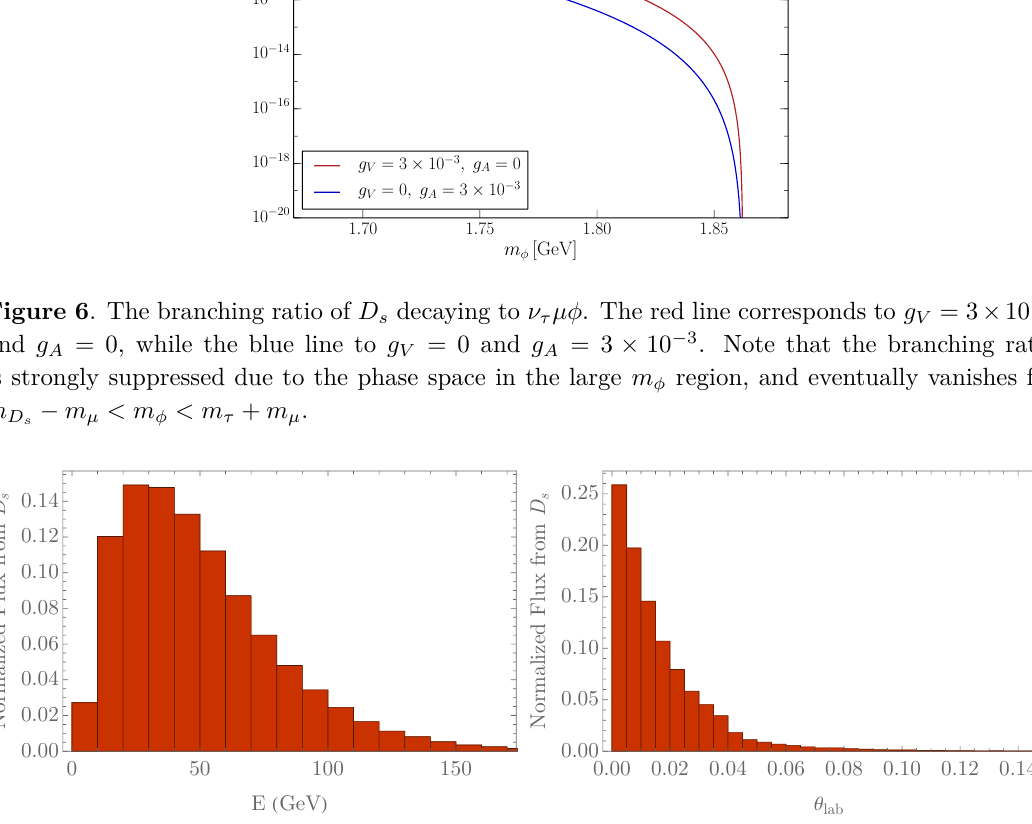
Figure 7 . The normalized differential energy distribution and the angular distribution from the D s production at SHiP